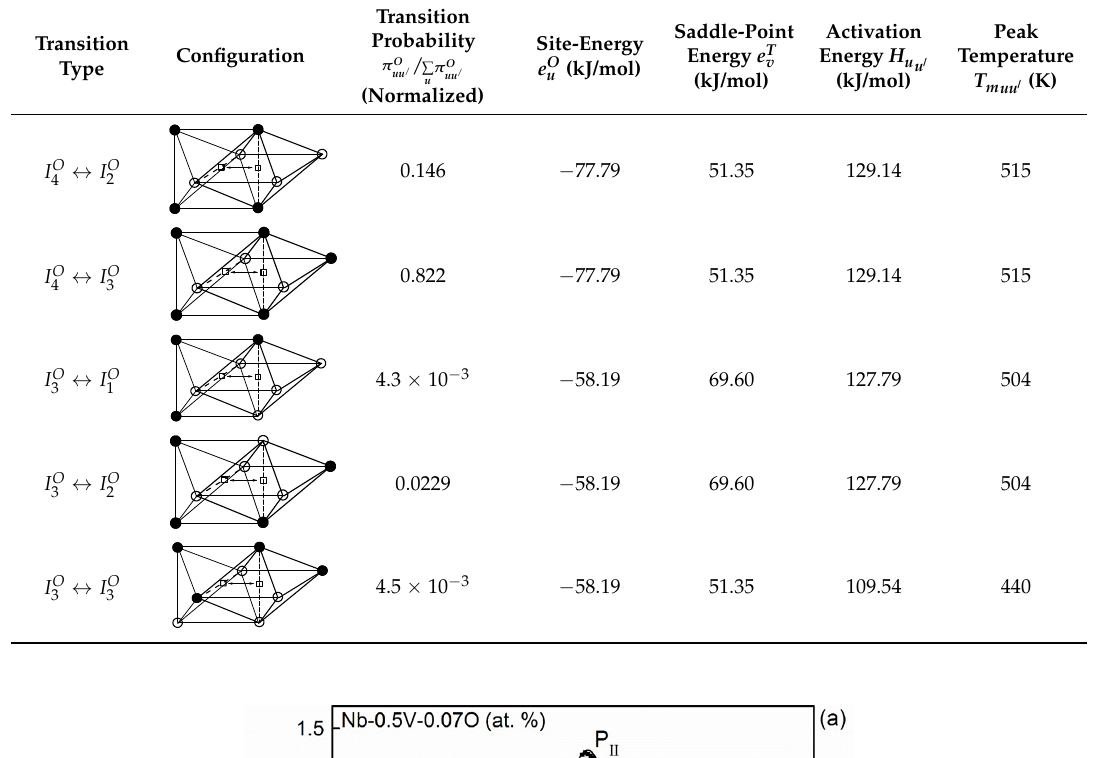
Table 2. The configurations and the relaxation parameters of all possible transitions of oxygen solute atoms in Nb–0.5V–0.07O (at. %) alloys ( ○ —Nb atoms, ● —V atoms).